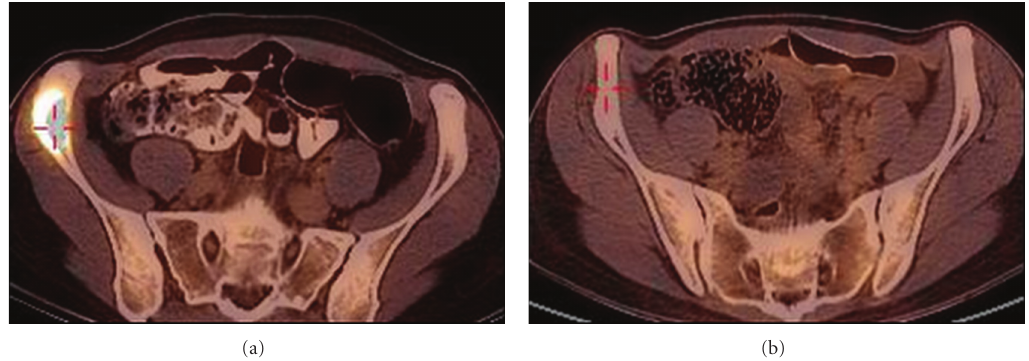
Figure 2: The same patient as on Figure 1. Bone metastasis in the right iliac bone (a) and complete response after treatment